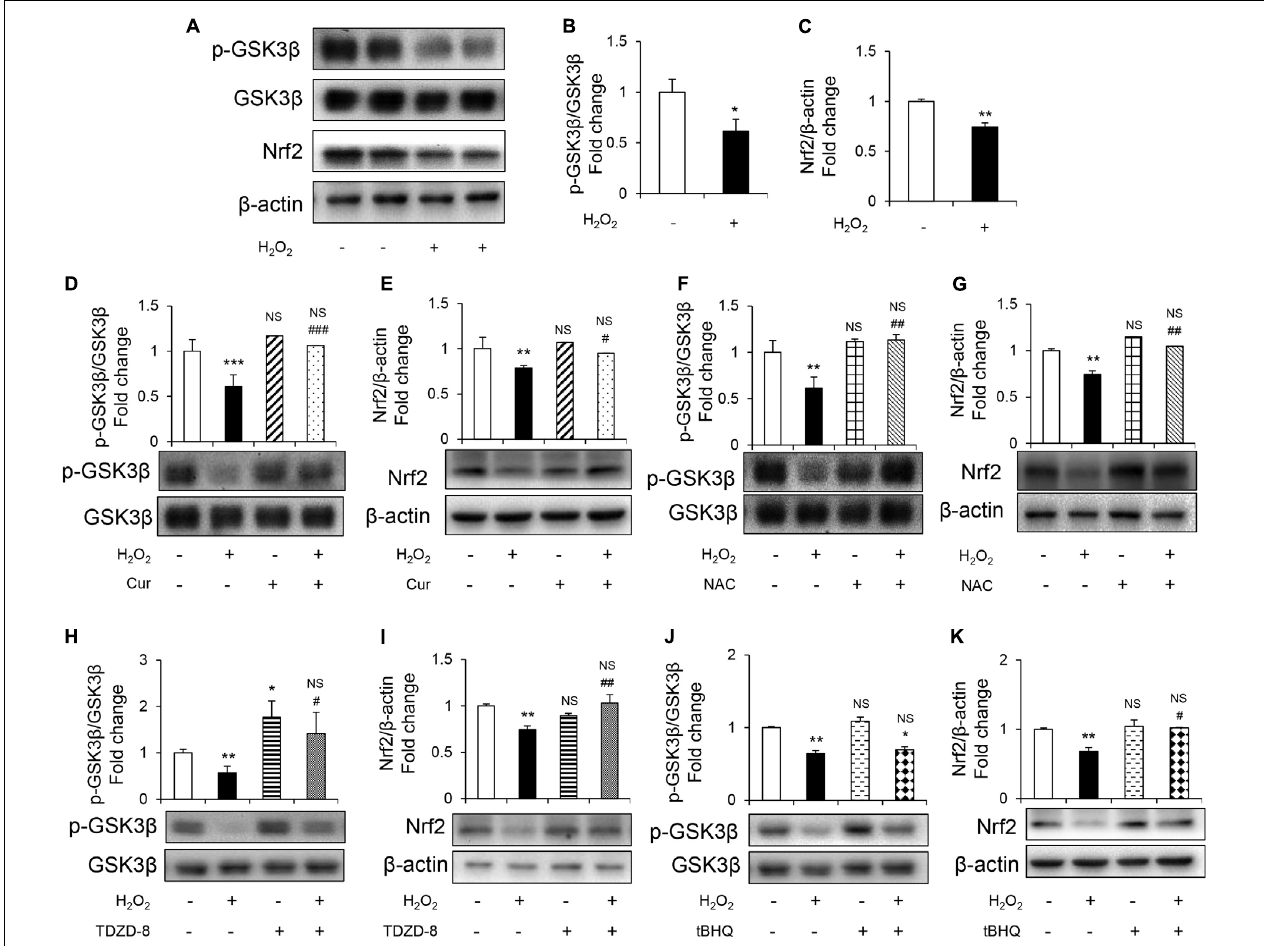
FIGURE 3 | Cur attenuated H 2 O 2 -induced osteoblast apoptosis through GSK3 β -Nrf2 signaling pathway. MC3T3-E1 cells were treated in the basic medium with or without H 2 O 2 for 6 h. (A) Representative immunoreactive bands for phosphorylated GSK3 β , GSK3 β , and Nrf2 in MC3T3-E1 cells. (B,C) Quantification of immunoreactive bands for phosphorylated GSK3 β relative to GSK3 β and Nrf2 relative to β -actin. (D,E) Cur was added 24 h before H 2 O 2 . Densitometry of immunoreactive bands for p-GSK3 β and GSK3 β , Nrf2 and β -actin in MC3T3-E1 cells with (+) or without (–) Cur in the presence of H 2 O 2 (+) or culture medium (–). (F,G) NAC was added 1 h before H 2 O 2 . Representative immunoreactive bands and relative levels of p-GSK3 β and GSK3 β , Nrf2 and β -actin in MC3T3-E1 cells with (+) or without (–) NAC treatment in the presence of H 2 O 2 (+) or culture medium (–).Representative immunoblots are shown at the bottom. (H,I) TDZD-8 was added 1 h before H 2 O 2 . Representative immunoreactive bands and relative levels of p-GSK3 β and GSK3 β , Nrf2, and β -actin in MC3T3-E1 cells with (+) or without (–) TDZD-8 treatment in the presence of H 2 O 2 (+) or culture medium (–). (J,K) tBHQ was added 1 h before H 2 O 2 . Representative immunoreactive bands and relative levels of p-GSK3 β and GSK3 β , Nrf2, and β -actin in MC3T3-E1 cells with (+) or without (–) tBHQ treatment in the presence of H 2 O 2 (+) or culture medium (–). Data are presented as the mean ± SD from at least three independent experiments. * p < 0.05, ** p < 0.01, *** p < 0.001, versus C group; NS, non-significantly different from C group. # p < 0.05, ## p < 0.01, ### p < 0.001, versus the H 2 O 2 group; ns, non-significantly different from H 2 O 2